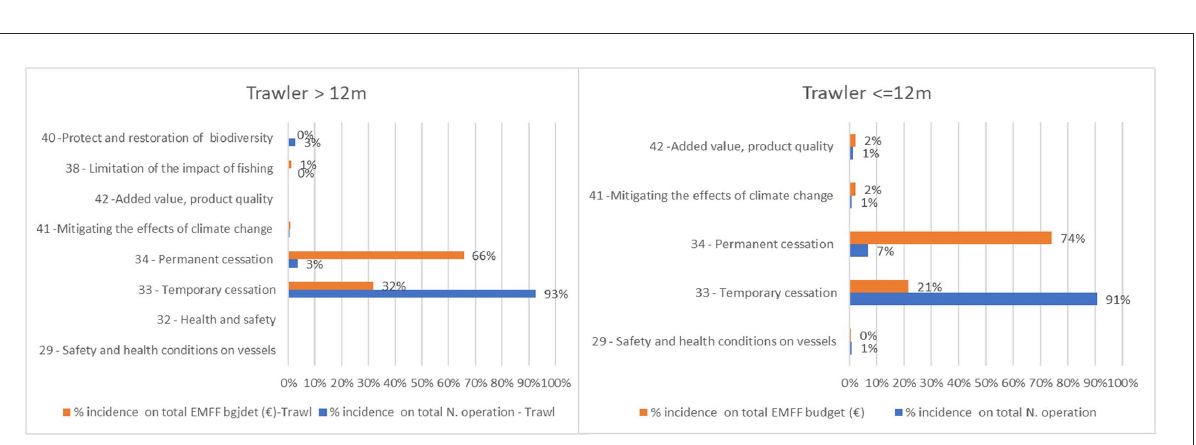
FIGURE4 EMMF measures allocated to the trawl fleet. Elaboration on data from the EMFF List of Operations and the EU Fleet Register of Italy, Croatia, Malta, Mediterranean Spain and Mediterranean